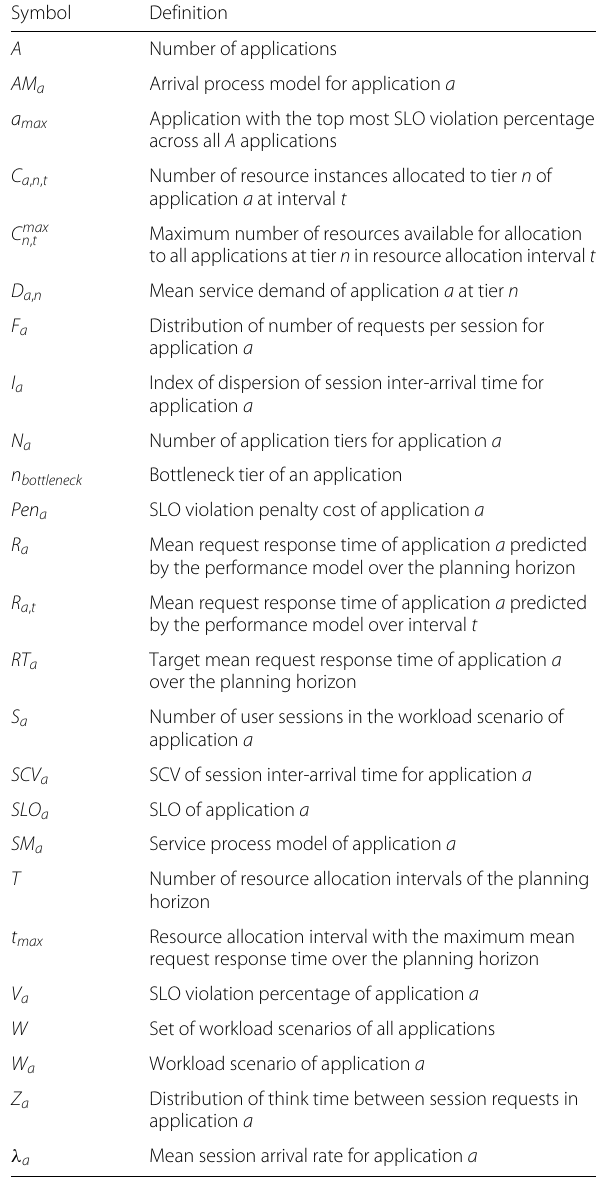
Table 1 Summary of